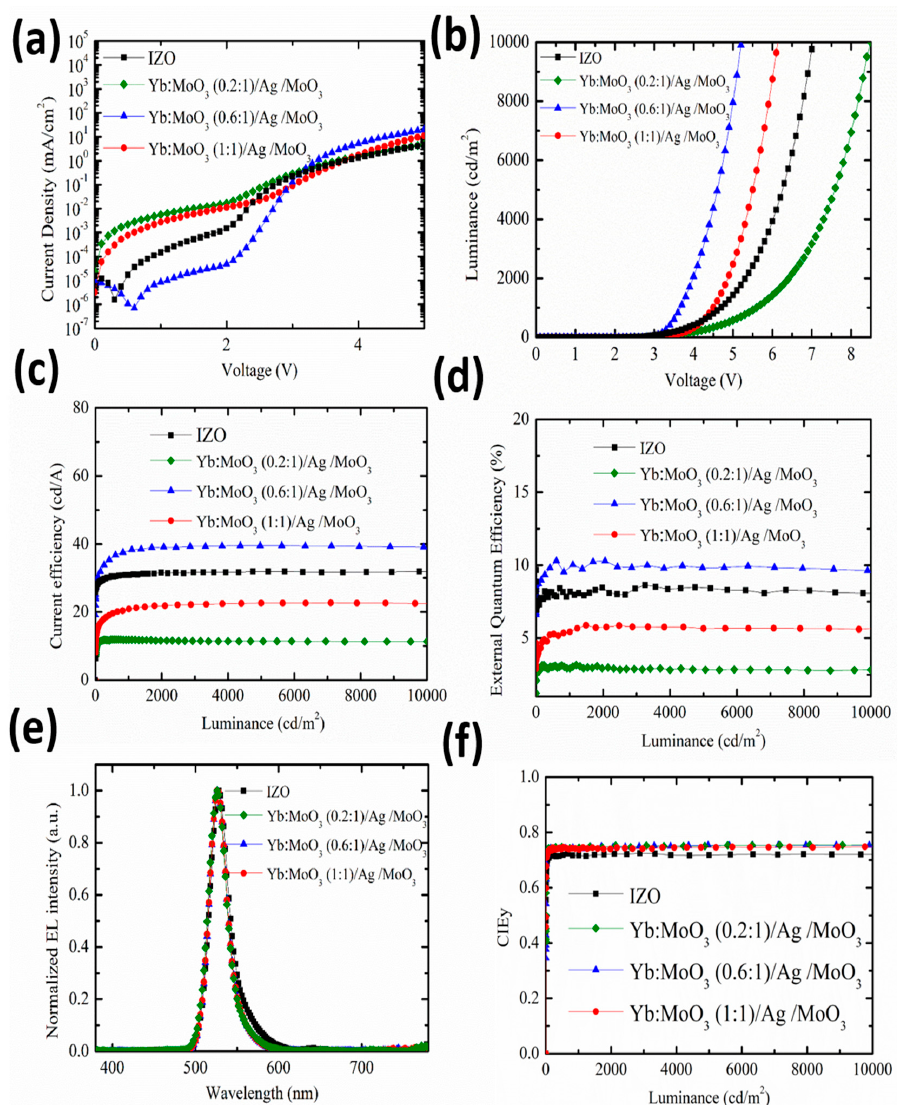
Figure 6. Device performance of the green top-emission QLEDs with di ff erent top transparent cathodes. ( a ) Current density voltage ( J – V ) characteristics. ( b ) Luminance current density ( L – J ) characteristics. ( c ) Current e ffi ciency luminance characteristics. ( d ) EQE luminance characteristics. ( e ) Normalized EL spectra. ( f ) CIEy luminance characteristics.